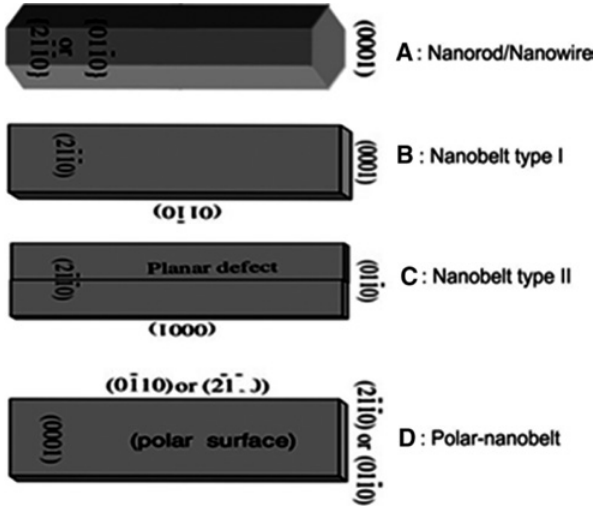
Figure 5: Typical growth morphologies of 1D ZnO nanostructures and the corresponding facets [2].